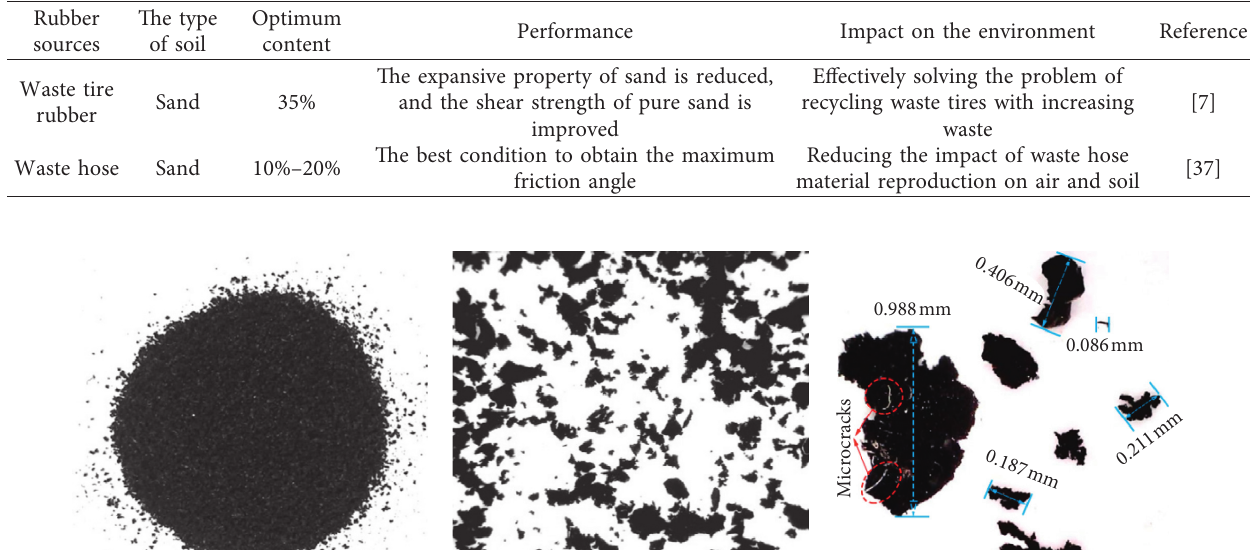
Table 1: Types of rubber in rubber reinforced